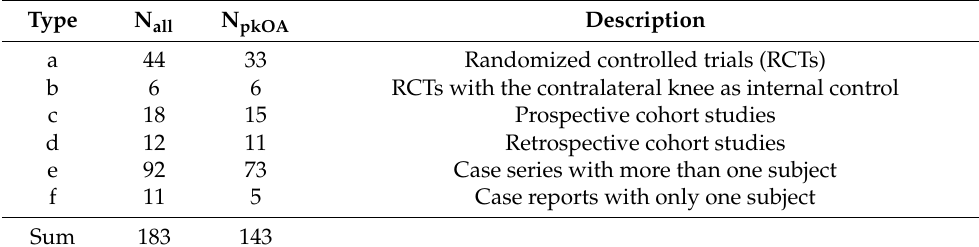
Table 7. Types of studies on treatment of primary knee osteoarthritis with stem cells that were identified during an evidence-based, systematic review of the literature according to the PRISMA guidelines [198] performed on 7 August 2021.